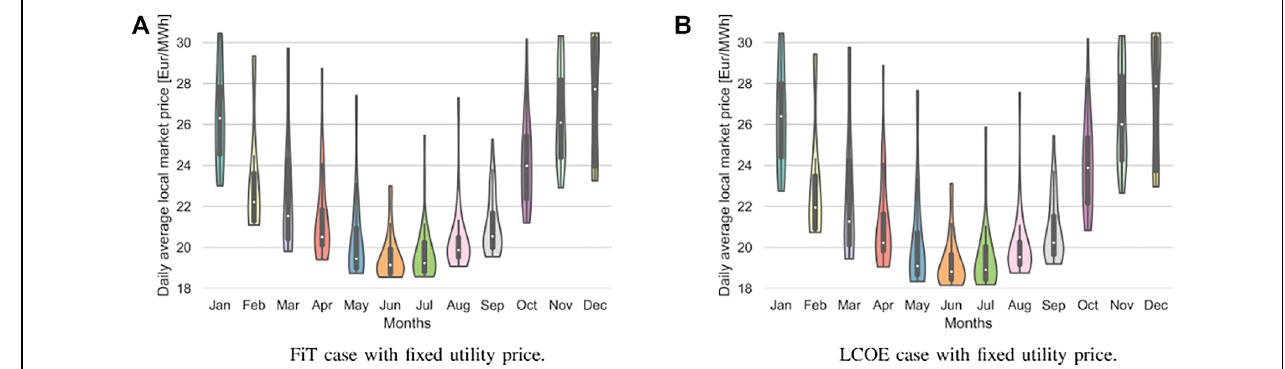
FIGURE 7 | Comparison of the daily average LEM prices for each month for the (A) FiT scenario and (B) LCOE scenario with fixed utility price.